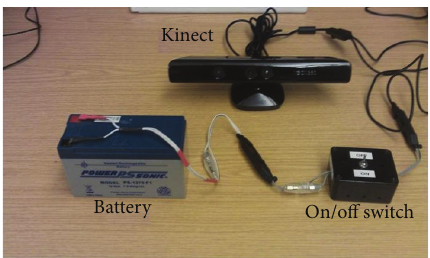
Figure 3: Components of the navigation system, excluding the laptop or equivalent on which all processing is